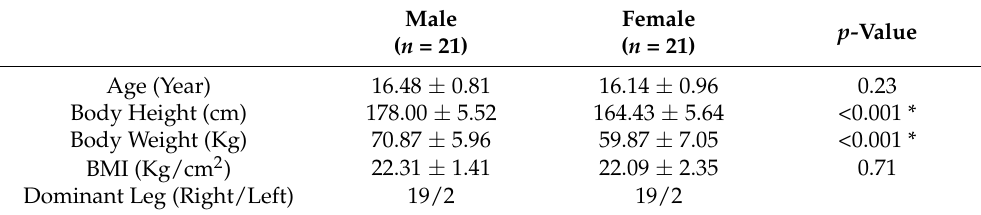
Table 1. Demographic data of participants.